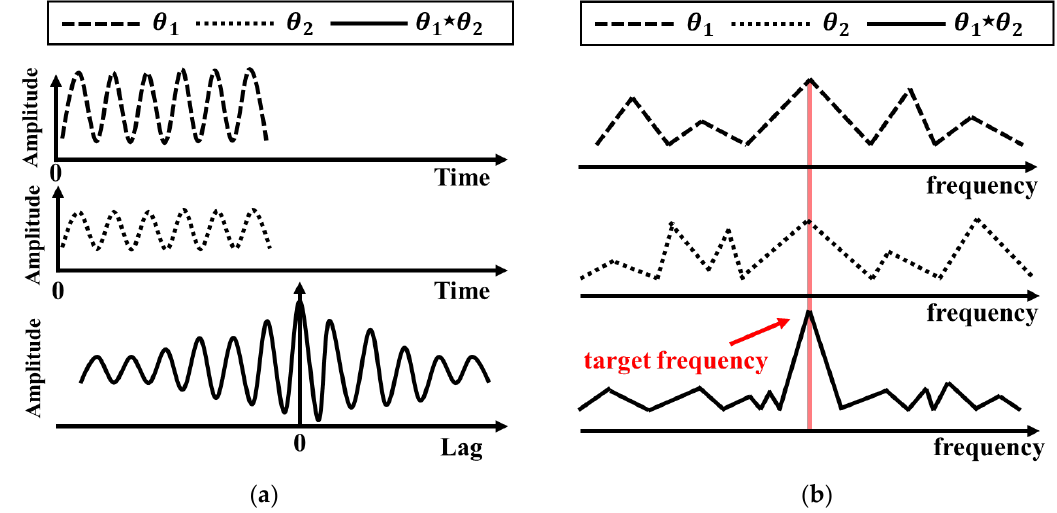
Figure 2. Cross-correlation method: ( a ) In the time domain; ( b ) in the frequency domain.